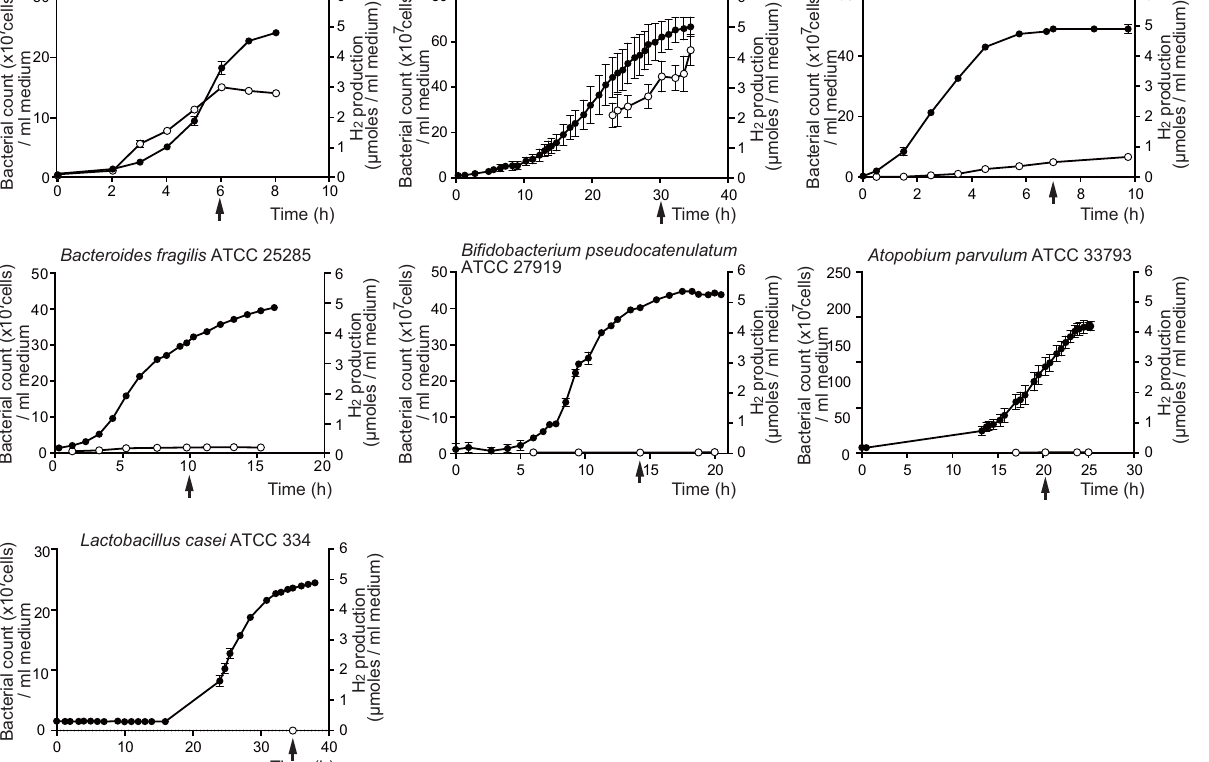
PLOS ONE | https://doi.org/10.1371/journal.pone.0208313 December26,